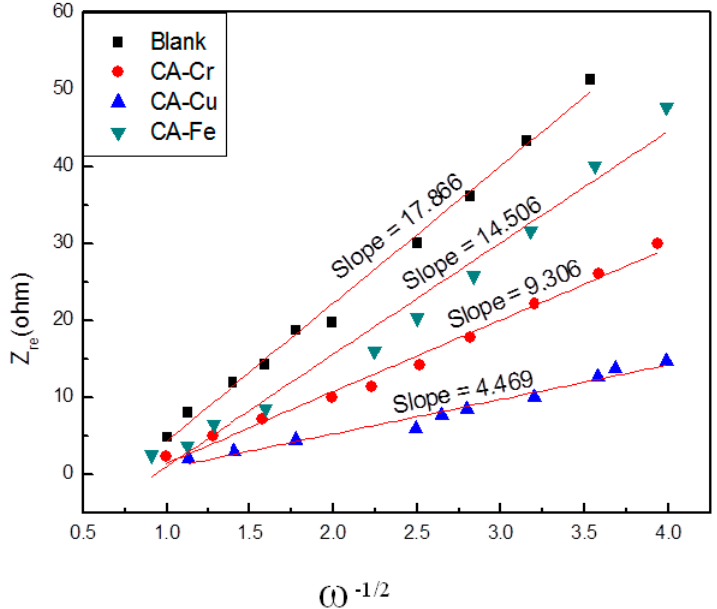
Figure 14. Nyquist graph of Z re plotted against ω − 1/2 of CA-X and the blank.